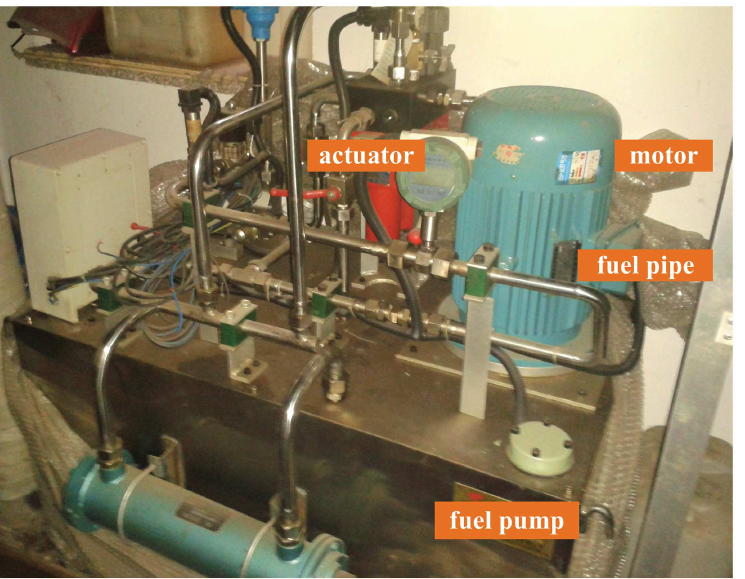
Fig 12. HIL system: actuator and fuel supply